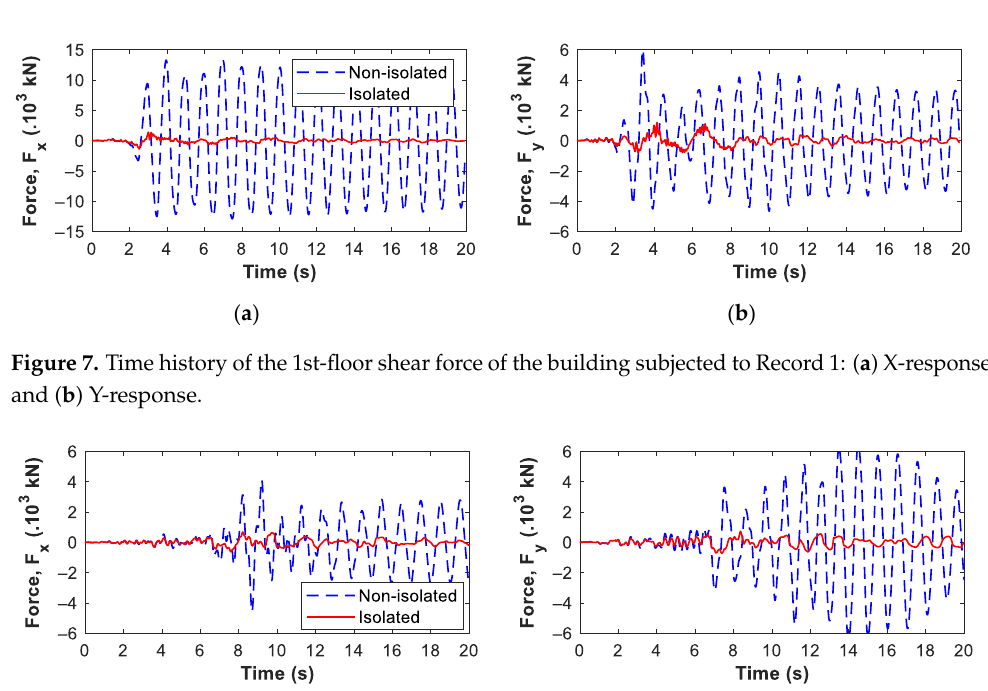
( b ) Figure 5. Time history of roof absolute acceleration of the building subjected to Record 1: ( a ) X- response and ( b ) Y-response. ( a ) ( b ) Figure 6. Time history of roof absolute acceleration of the building subjected to Record 2: ( a ) X-